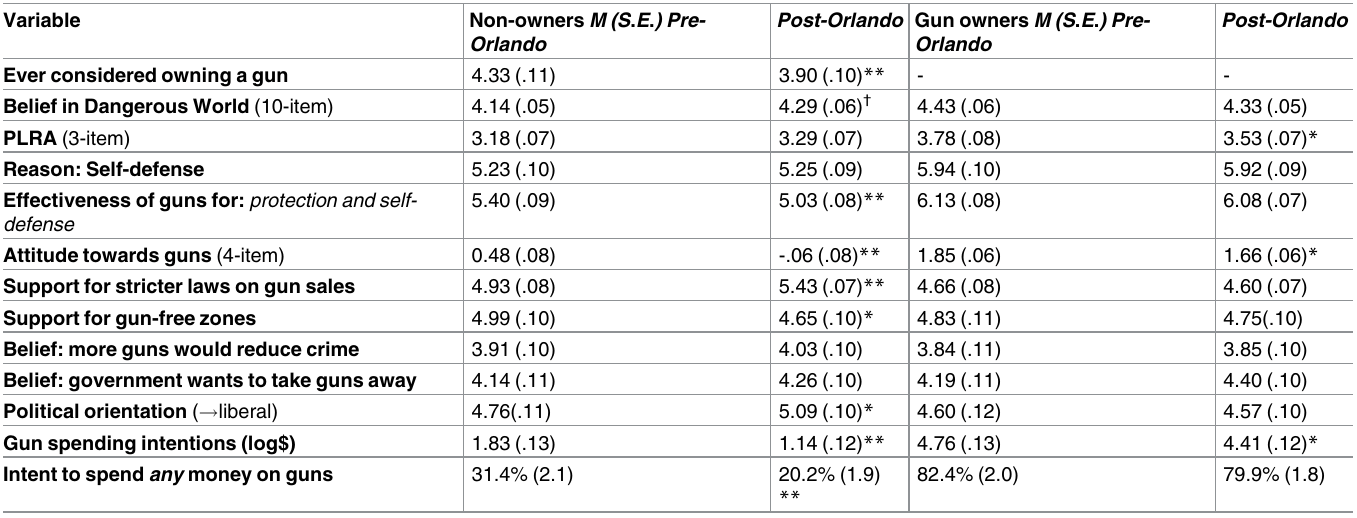
Table 1. Means by gun ownership and Orlando. Asterisks represent a significantpre-post-Orlando difference (within gun ownershipgroup). ** p < .01, * p < .05, † p < .06.